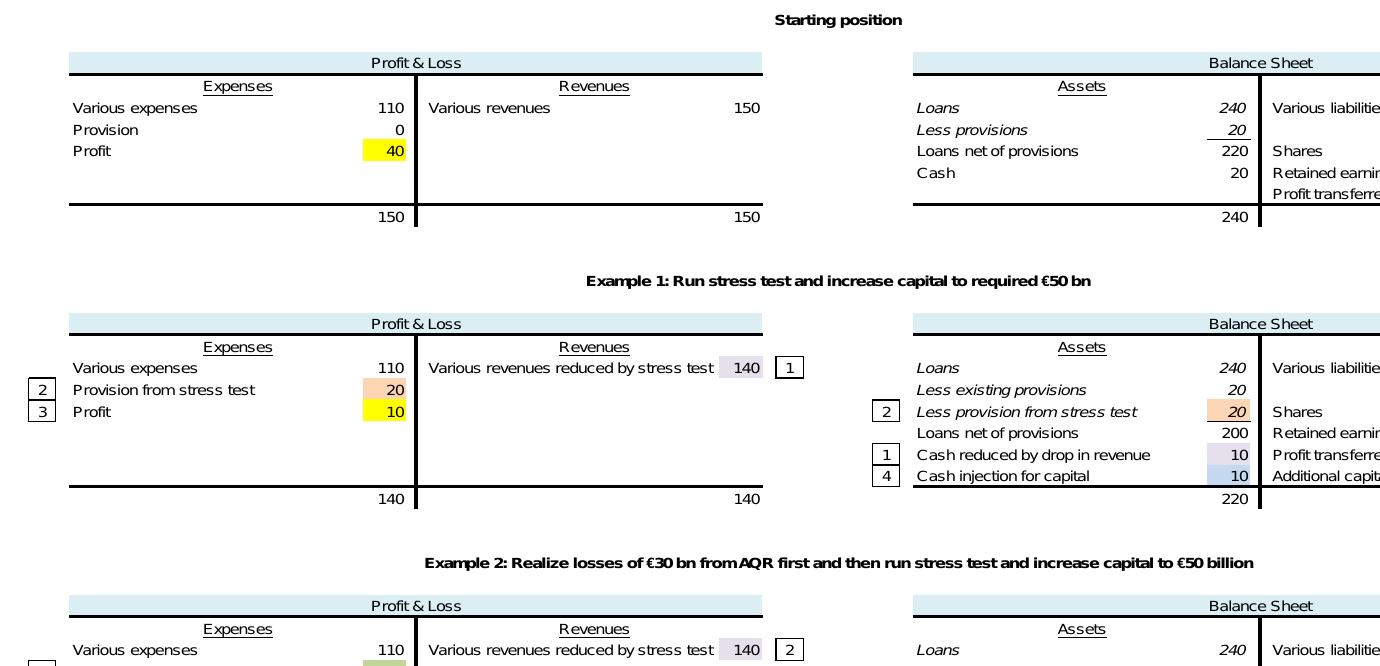
Figure A1. Accounting Entries: Loss Recognition, Provisioning and Recapitalization (In billions of